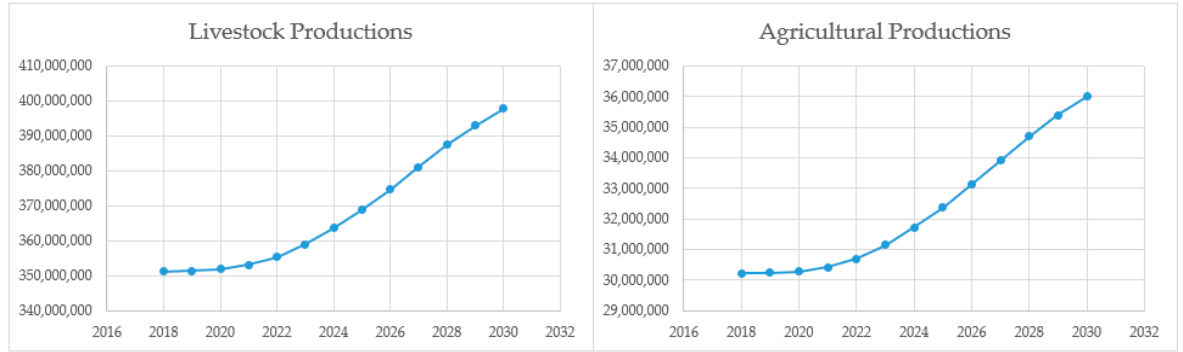
Figure 5. The result of predicting agricultural and livestock production for the next ten years in Iran.